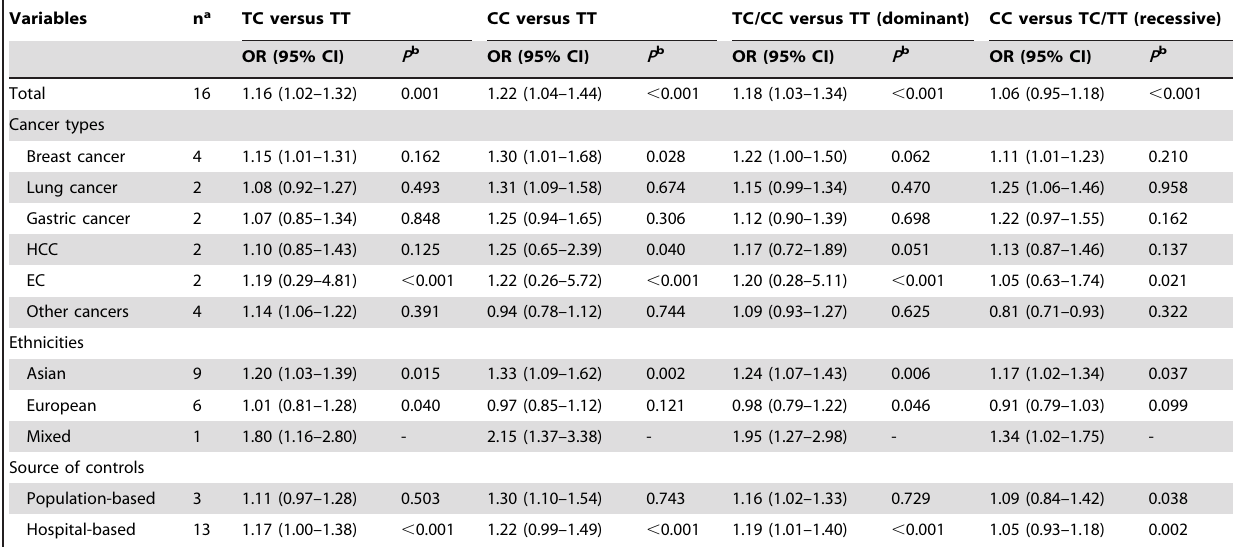
Table 2. Meta-analysis for the hsa-miR-196a2 rs11614913 polymorphism and cancer risk.